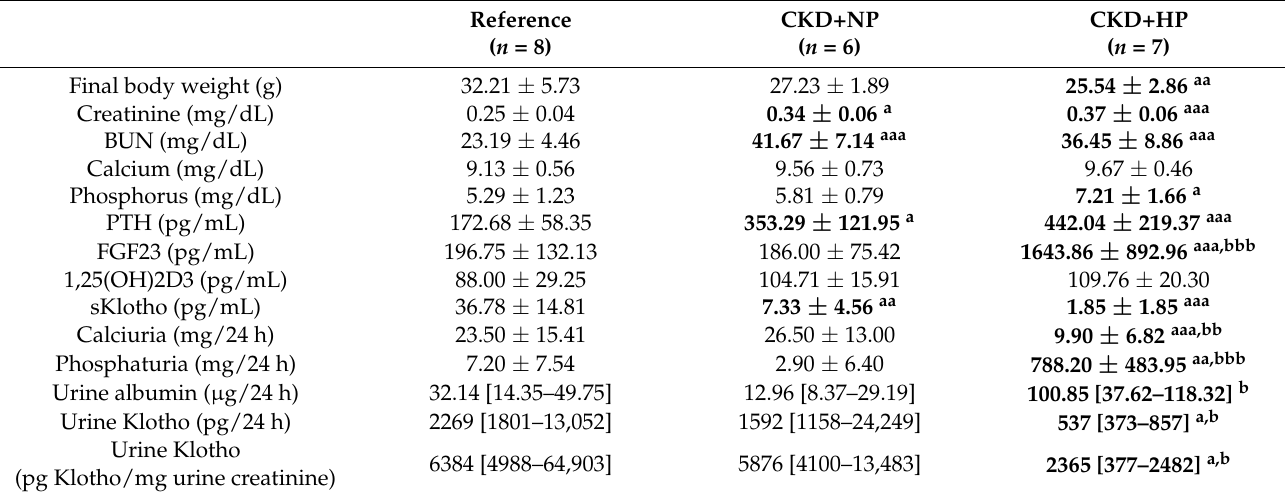
Table 1. Weight and biomarkers of kidney dysfunction in the in vivo